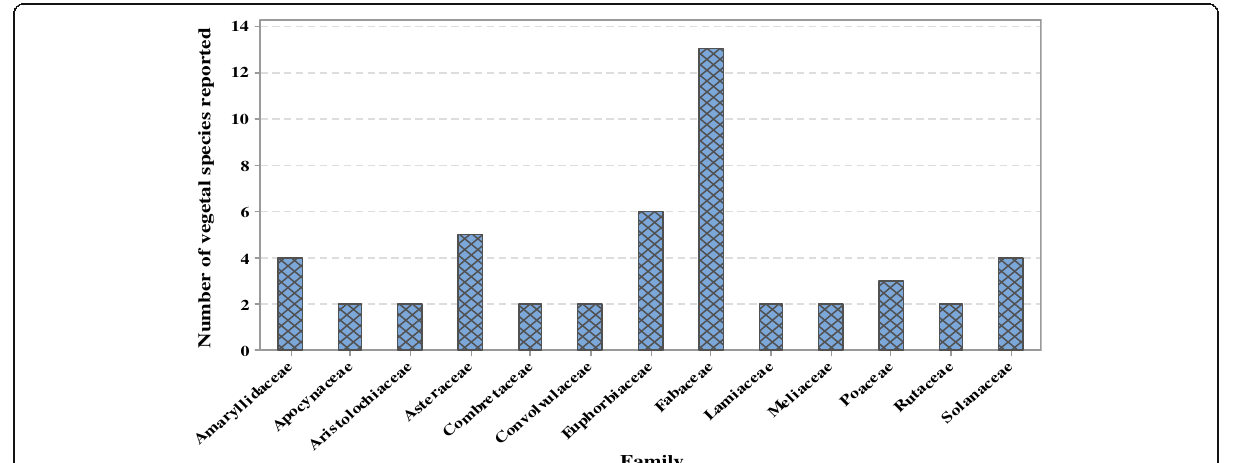
Fig. 2 Major families from which vegetal antivenins are obtained in Uganda